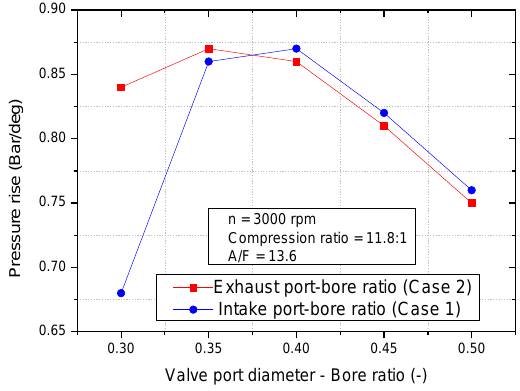
Figure 14. Pressure increase versus VPD / B.